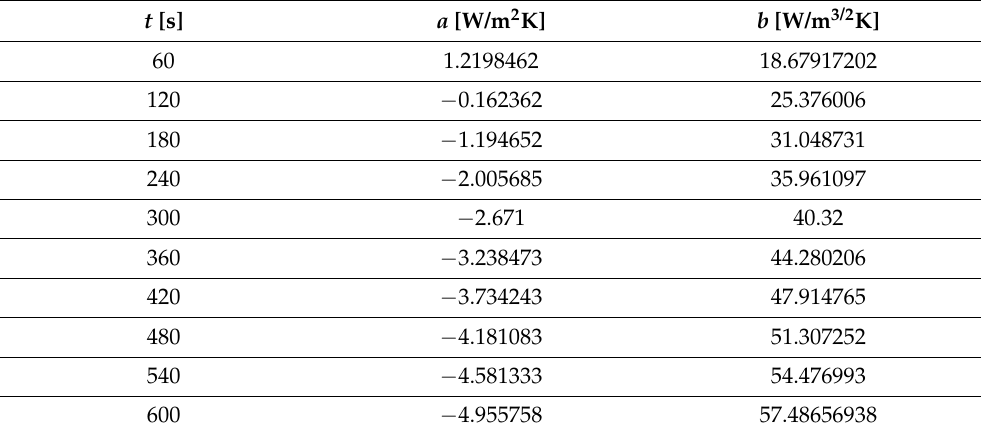
Table 1. Coefficients of the function approximating the distribution of the convective heat transfer in time and space in Equation (13).